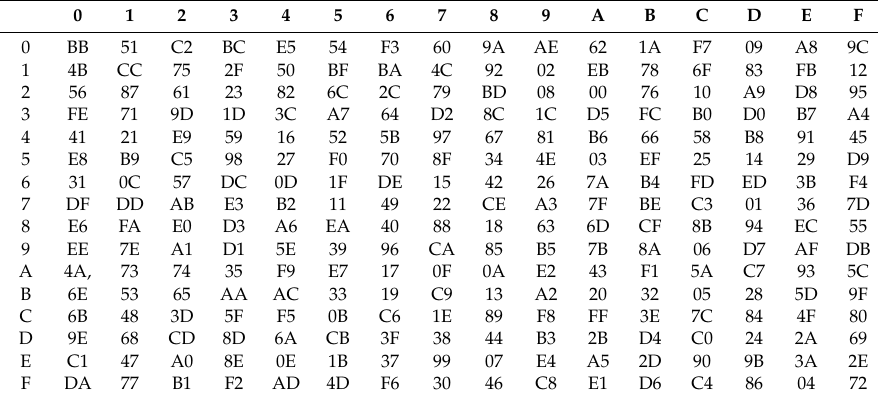
Table 3. Key and plaintext dependent S-Box with KSA and PRGA enforced by Henon Chaotic Map with key